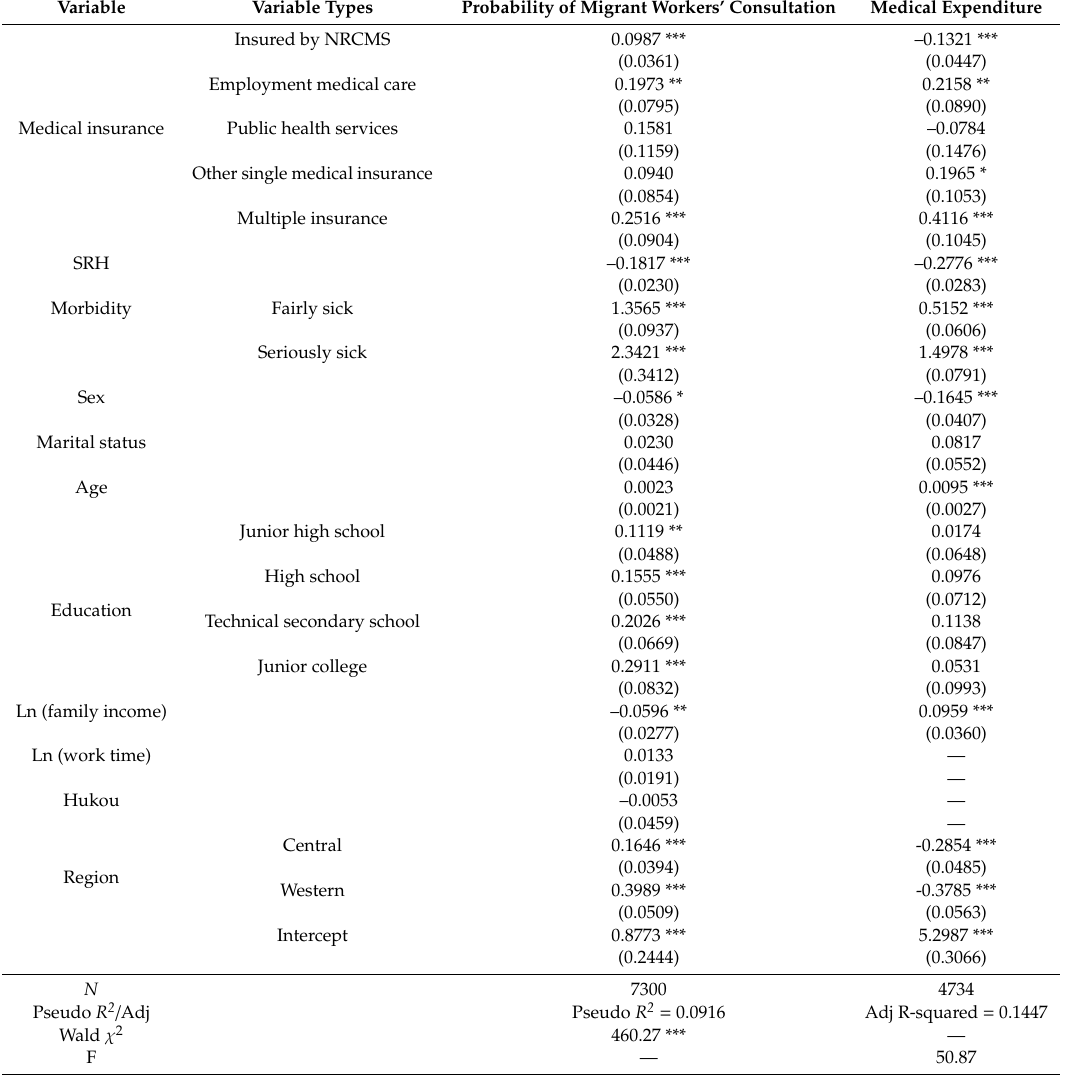
model. Table 4 reports the Tobit regression results for migrant workers’ medical burden. Table 5 reports probit regression results for migrant workers’ utilization of preventive medical services. Table 2. The TPM regression results for migrant workers’ medical